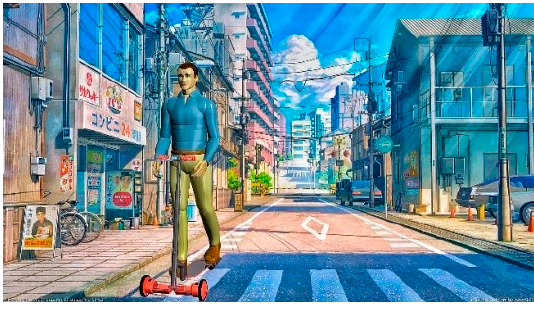
Figure 13. Final rendering.